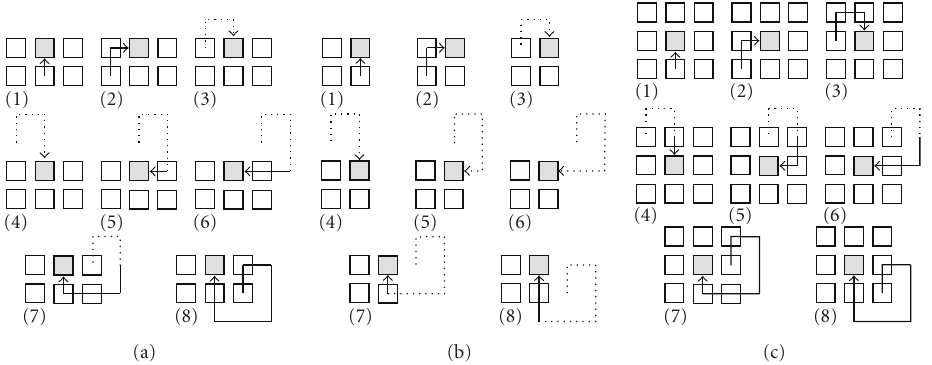
have the value of their neighboring boundary nodes available locally. This requires two additional bu ff ering elements to store the values, but the e ff ect on area utilization is kept at a minimum. Overall, 3 time steps are introduced for each newly calculated y